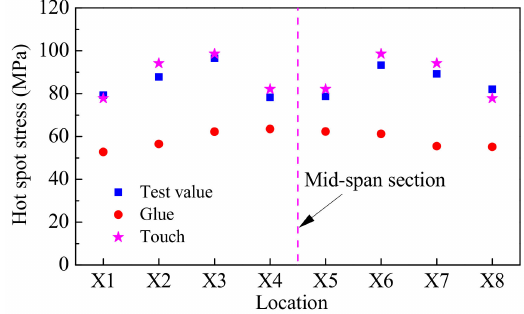
Figure 17. Comparison of different contact